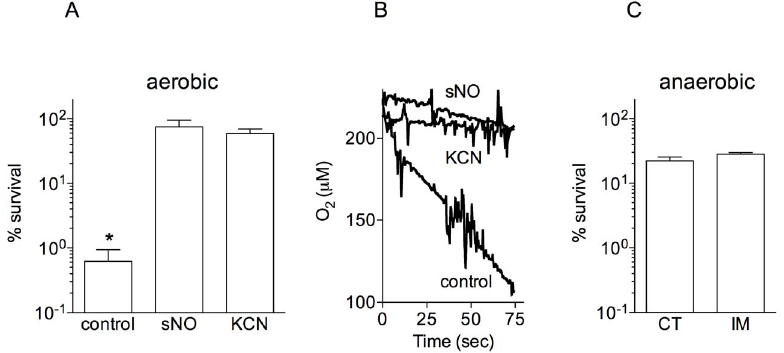
Figure 3. Respiratory activity of B.pseudomallei undergoing nitrosative stress. Survival of B. pseudomallei after 2.5 h of treatment with 12.5 m g/ml of imipenem (A). Some of the specimens were co-treated with either 500 m M potassium cyanide (KCN) or 100 m M spermine NONOate (sNO). The percent survival was determined as described in figure 1. The data are the mean 6 SD from 3 observations collected on 3 separate days. The ability of B. pseudomallei to consume O 2 was monitored polarographically (B). The data shown in panel B are representative from 3 independent experiments. B. pseudomallei were adapted for 5 h in an anaerobic chamber and the % survival scored 2.5 h after the addition of 64 m g/ml ceftazidime (CT) or 25 m g/ml imipenem (IM) (C). The results in C are expressed as % survival over controls that were not exposed to antibiotics. B. pseudomallei controls in the anaerobic chamber neither grew nor lost viability in the time frame tested. p , 0.01 compared to sNO- and KCN-treated